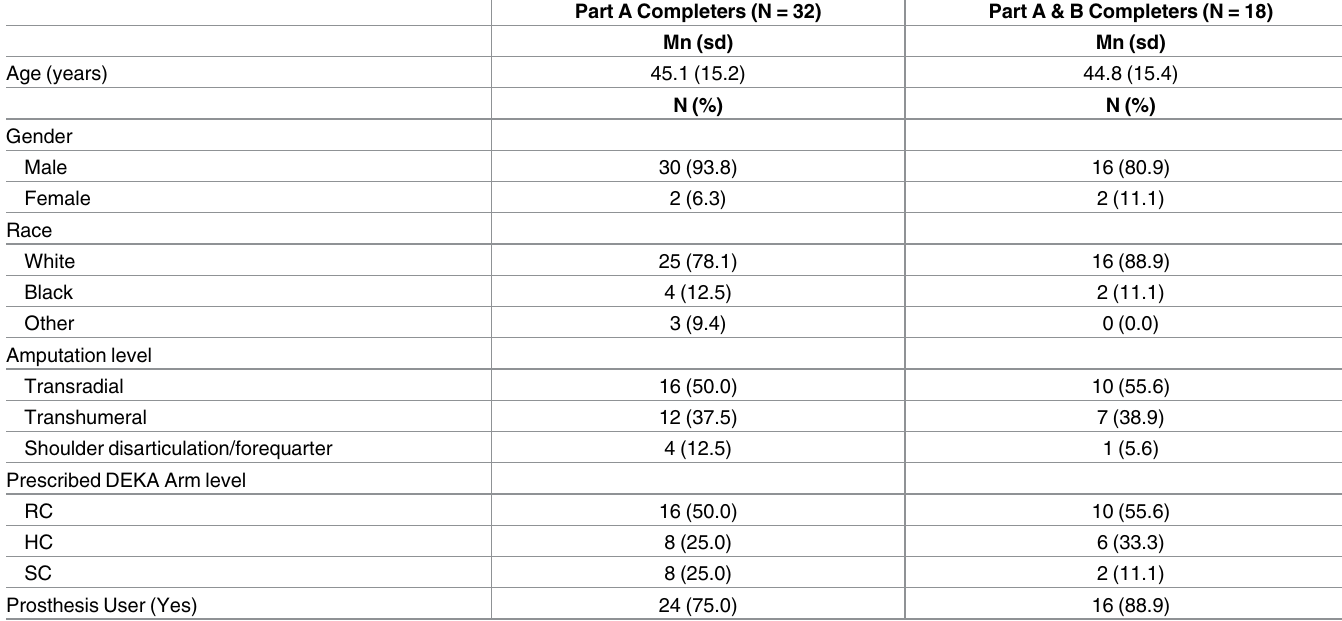
Table 1. Characteristics of